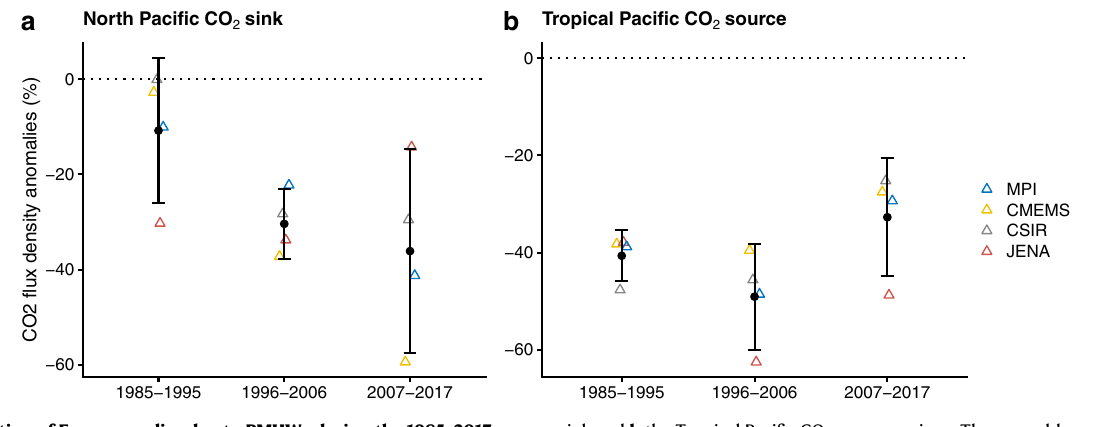
sink and b the Tropical Paci fi c CO 2 source regions. The ensemble mean and stan- dard deviation are given in black. An additional 12% uncertainty resulting from uncertain gas exchange 60 has been added to the ensemble spread. The calculation of the percent F CO2 anomalies is detailed in the method